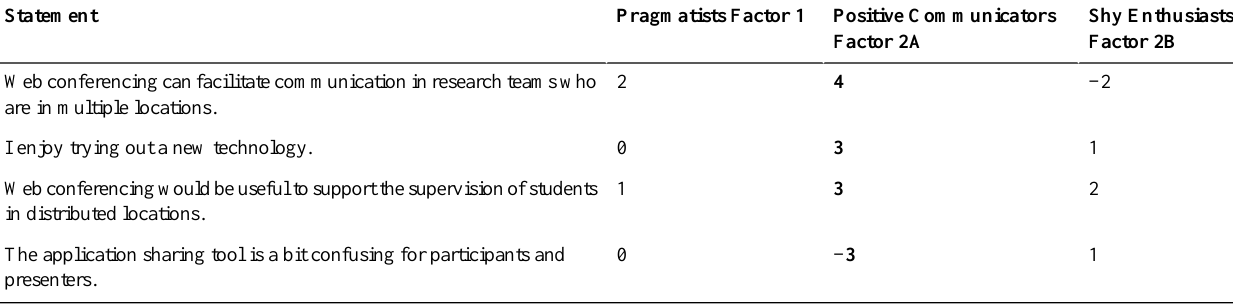
Table 3. Factor 2A scores for distinguishing statements for positive communicators (n =